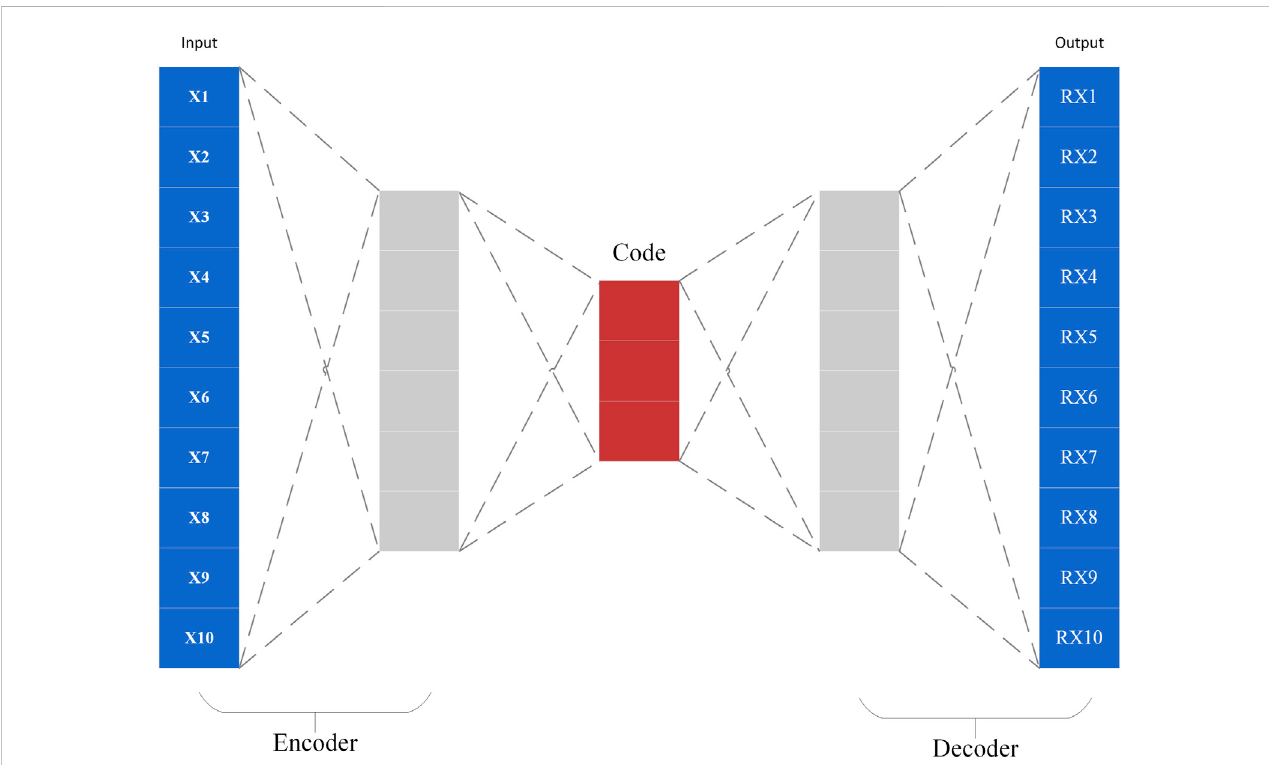
FIGURE 3 Graph example illustrating the encoder – decoder architecture of auto-encoder. First the input passes through the encoder, which is a fully-connected ANN, to produce the code. The decoder, which has the similar ANN structure, then produces the output only using the code. Final calculation of the original and reconstructed image as